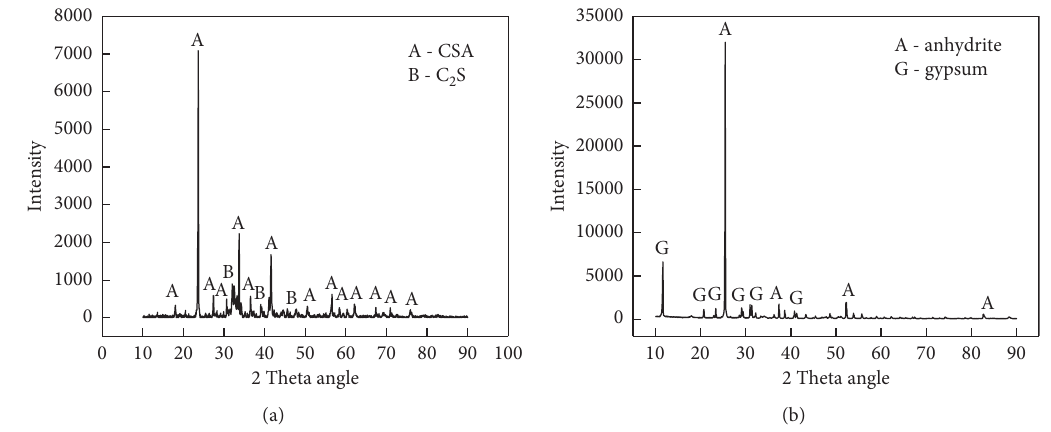
Figure 1: The XRD pattern of binder materials of the HWBM: (a) material A and (b) material B.